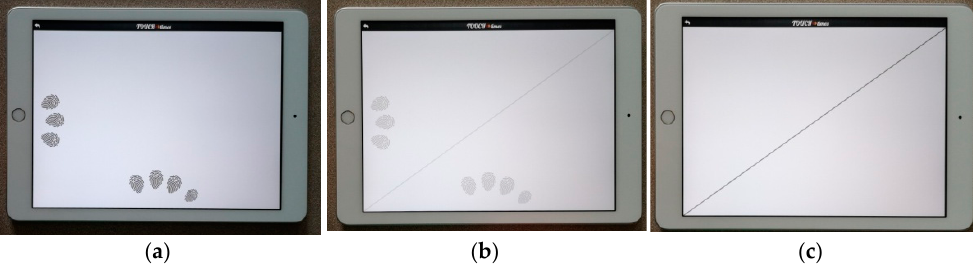
Figure 5. ( a ) Fingerprints, ( b ) Fingerprints and the diagonal line, ( c ) The diagonal line.